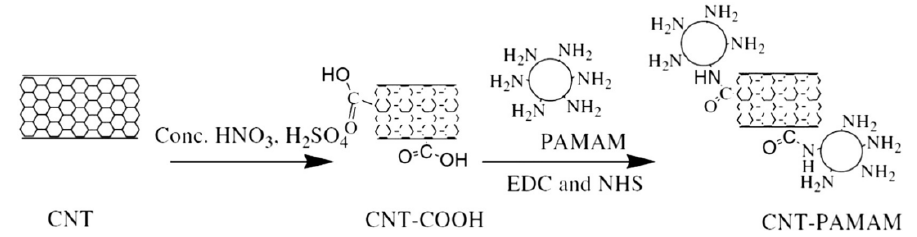
Figure 5. Synthesis process of PAMAM/CNT nanocomposite .Reprinted with permission from Ref. [71]. 2016, Elsevier.